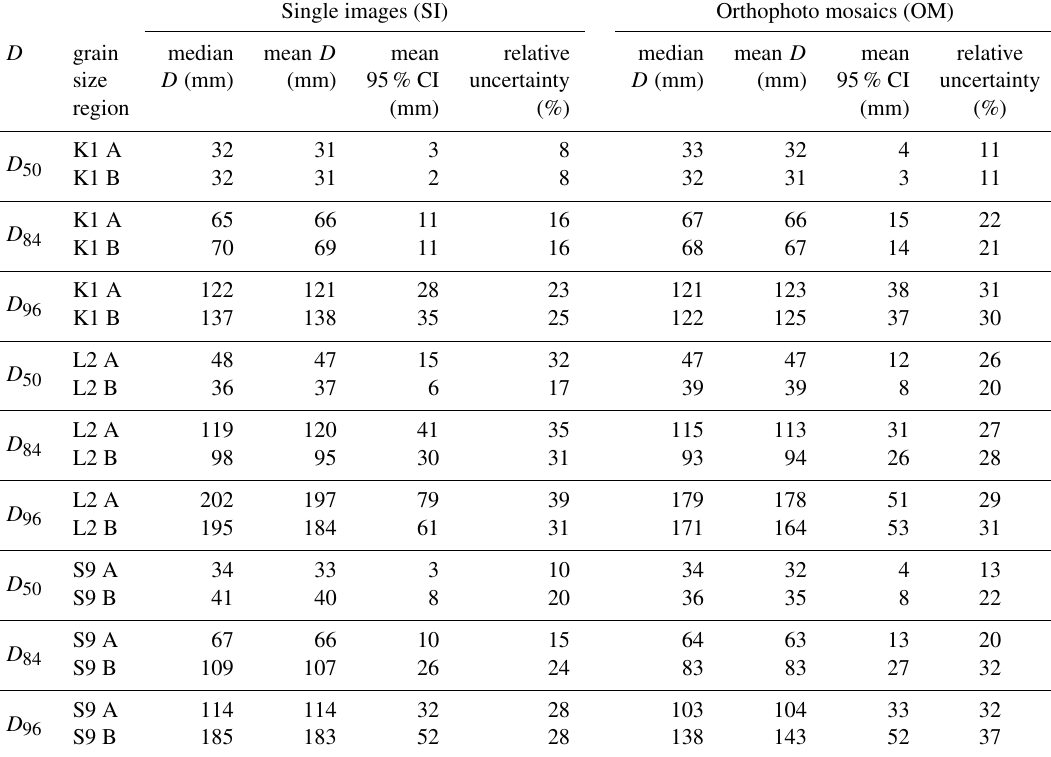
Table 3. Key modeled percentile results (i.e., D 50 , D 84 , and D 96 ) averaged over all models for each grain size region. Single images